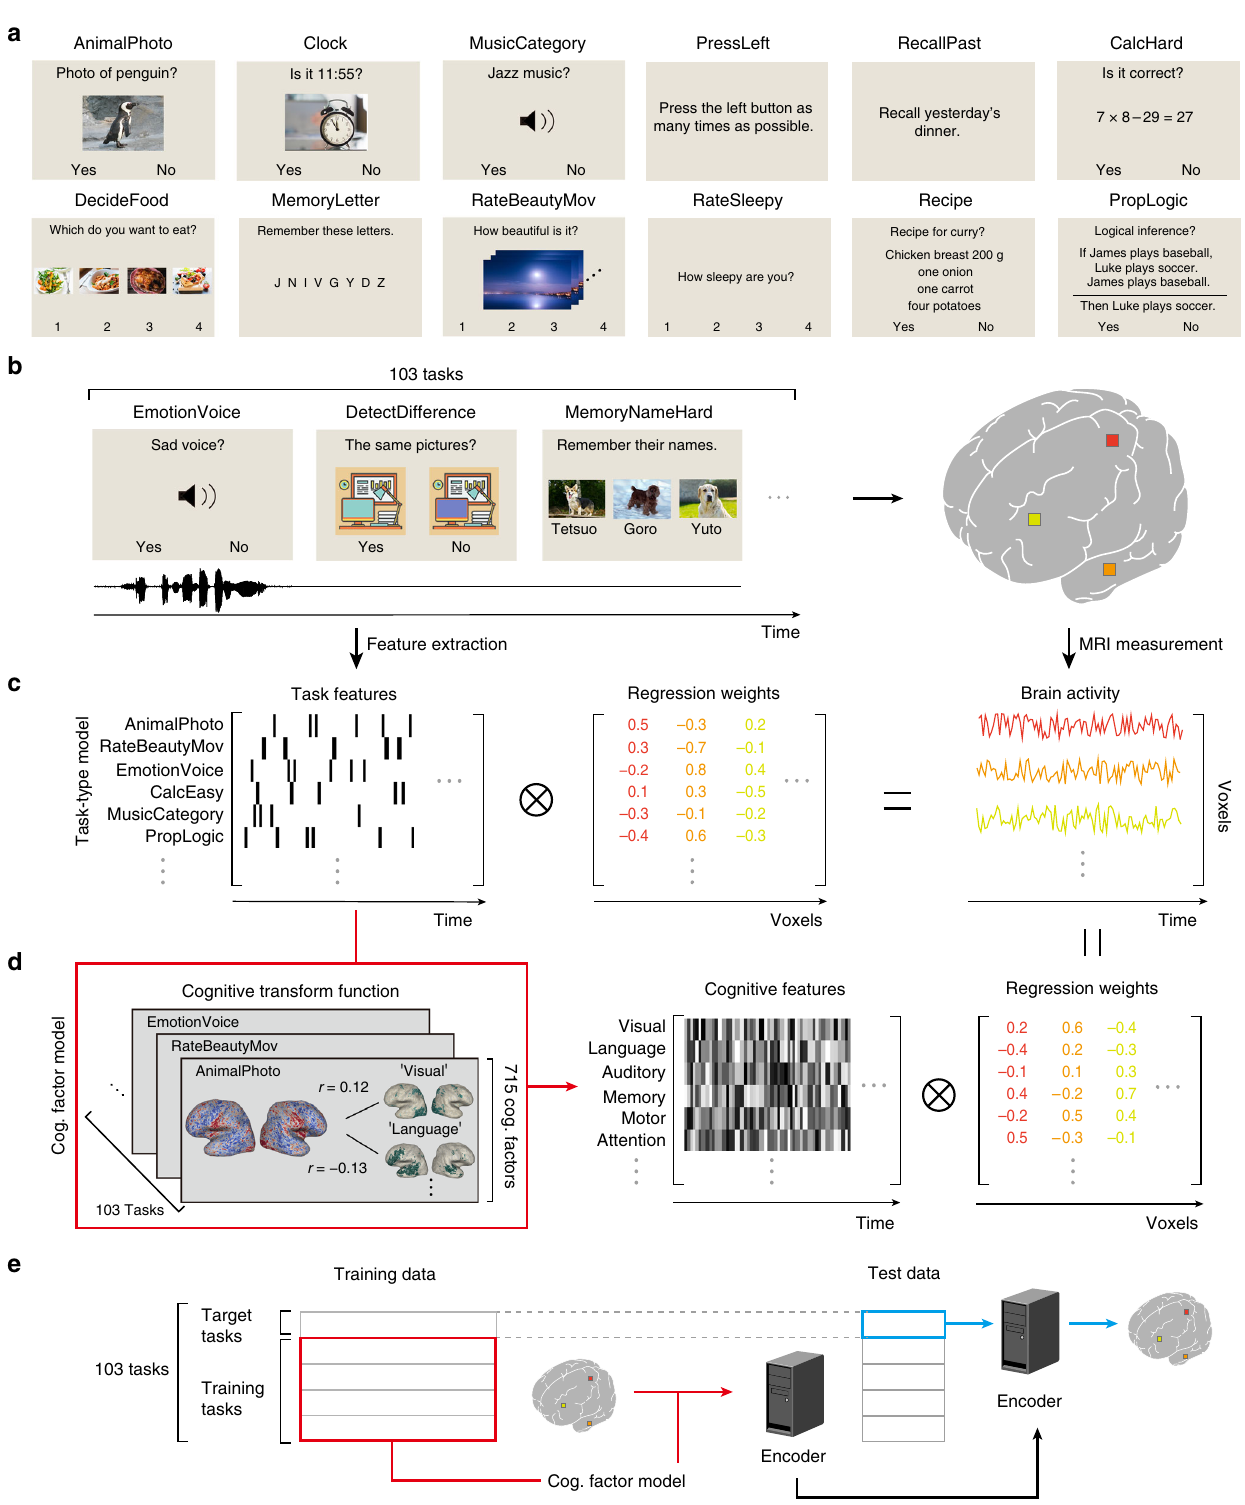
Fig. 1 Schematic diagrams of the task setting and analysis methods. a Example image of 12 tasks, with task names described at the top. b The subjects performed 103 naturalistic tasks while the brain activity was measured using functional MRI. c Schematic of the encoding model fi tting using the task-type model. d Schematic of the cognitive factor model. The cognitive transform function was calculated based on correlation coef fi cients between the weight maps of each task and the 715 metadata references 13 . Task-type features were transformed into cognitive factor features. e Schematic of the encoding model fi tting using the cognitive factor model for novel tasks. Target tasks were not included in the model training datasets (in red). The trained encoder provided a prediction of brain activity (in blue). Note that some visual images used in the tasks are different from the original because of copyright protection. Penguin, clock, food, sky, desktop illustration, and dog images are provided by